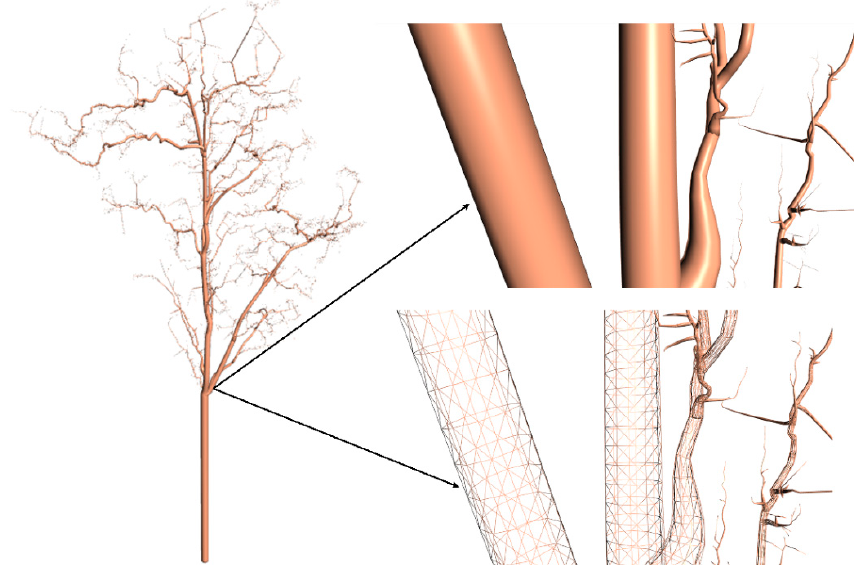
Figure 5. Tree stem and branches were fitted to the constructed tree skeleton.